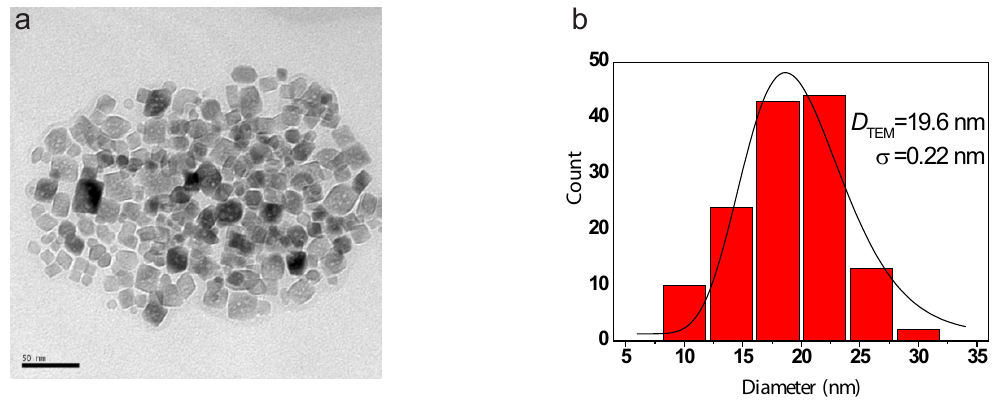
Figure 3. (a) TEM micrograph and (b) size distribution histogram of sonochemically synthesized Mn